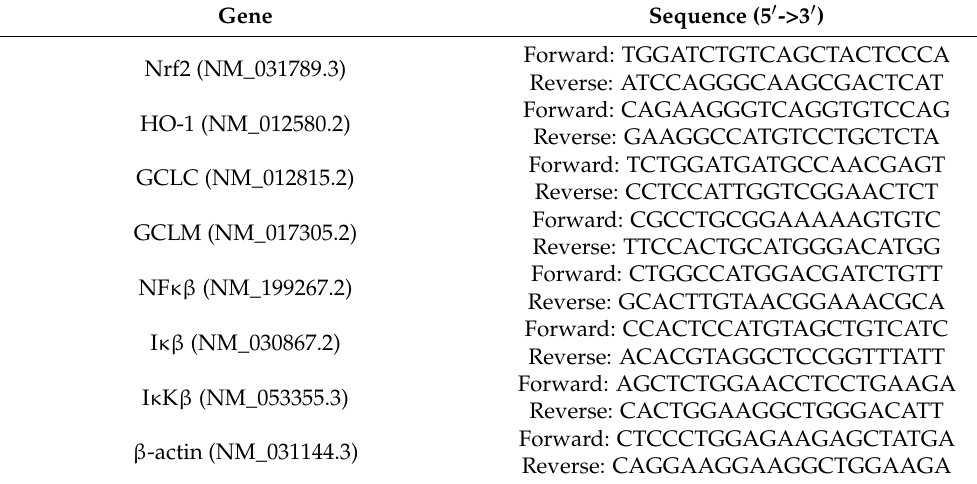
Table 1. Primer sequence for real time quantitative PCR.